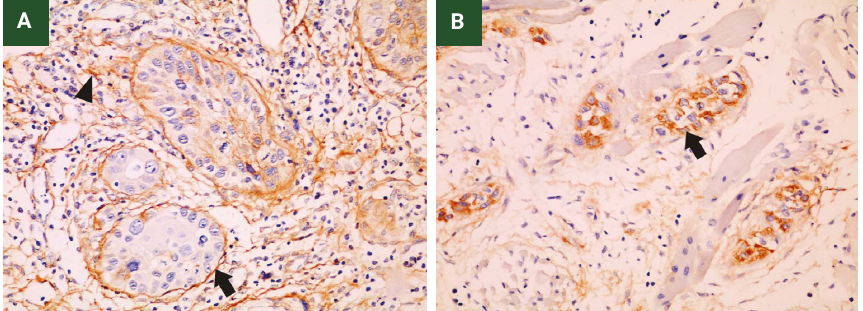
Figure 3. a) Immunoexpression of tenascin in SCCTo throughout peritumoral basement membrane (arrow) in linear and thin pattern and tumor stroma (arrowhead) (LSAB method, original magnification ×400). b) Intense cytoplasmic immunoexpression of tenascin in deepest nests (arrow) (LSAB method, original magnification ×400).